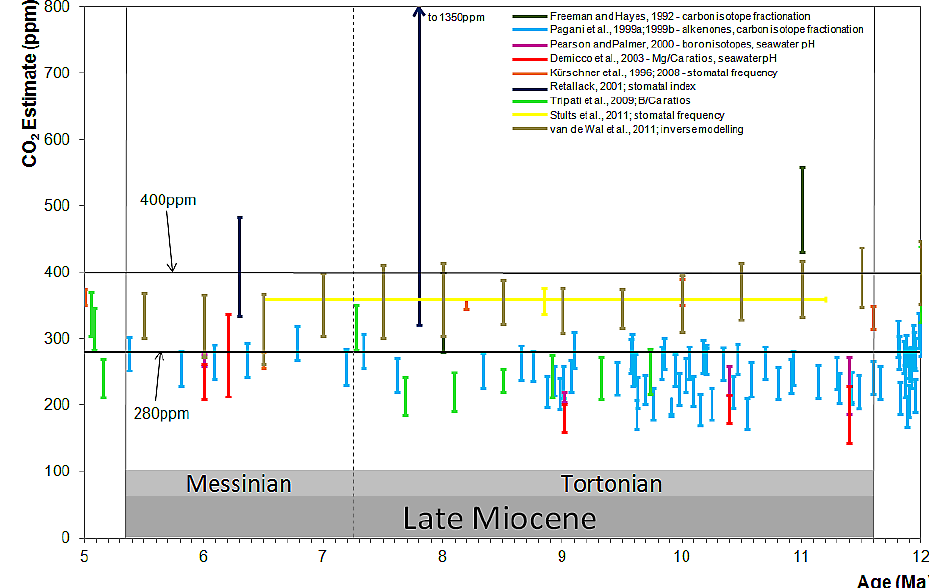
Fig. 1. Atmospheric CO 2 reconstructions for the late